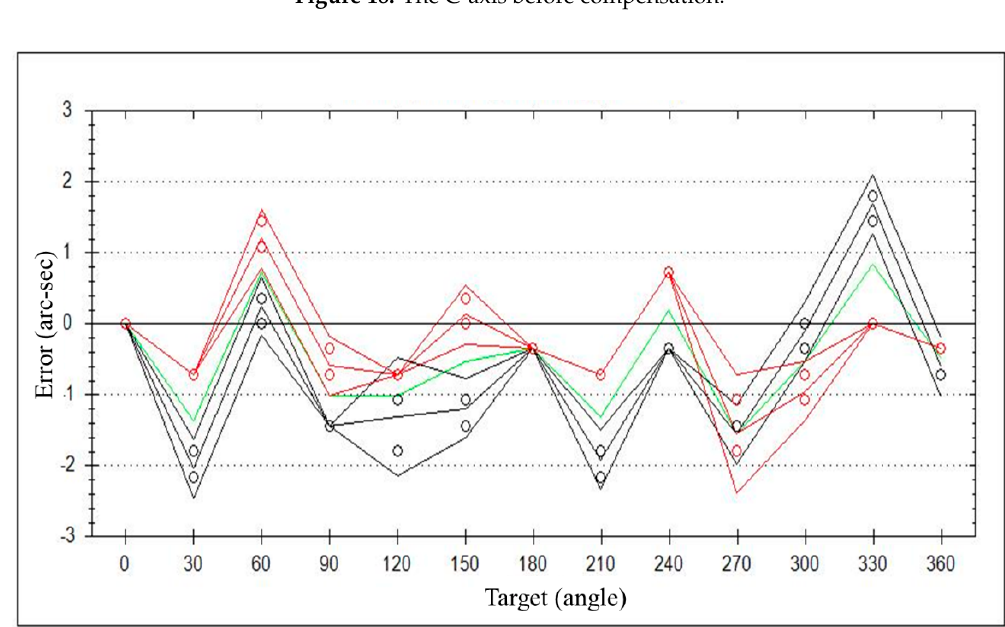
Figure 18. The C-axis before compensation.